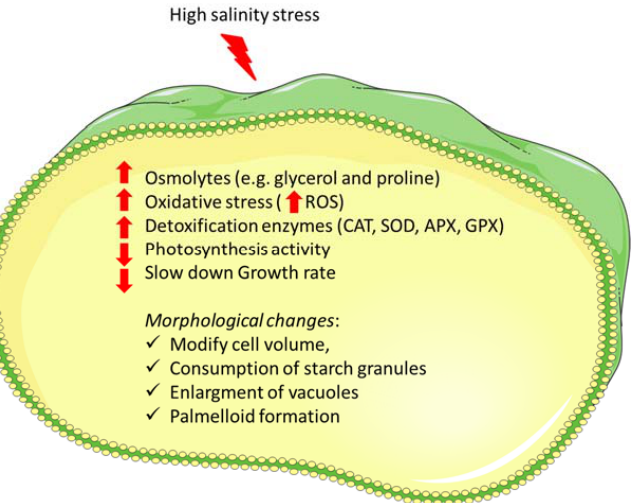
Figure 1. Main physiological and morphological effects observed in Chlamydomonas spp. exposed to high salinity stress.